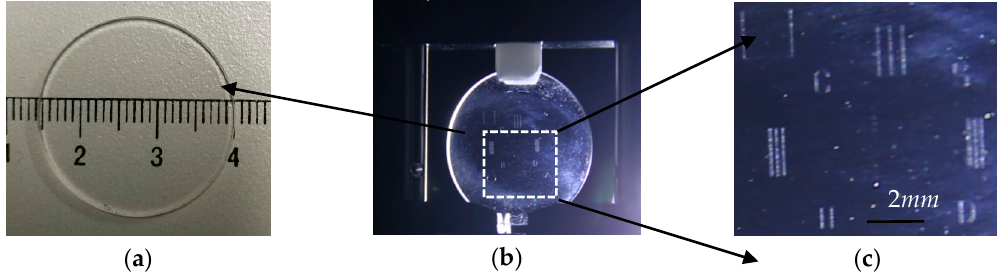
Figure 5. A letter “C” engraved on the glass plate as test sample. ( a ) Dimension figure for glass plate; ( b ) Test sample on system setup; ( c ) Partial enlarged view of Figure 5b. The letter ‘C” is seen on the second quadrant of the figure. After Reference [18].